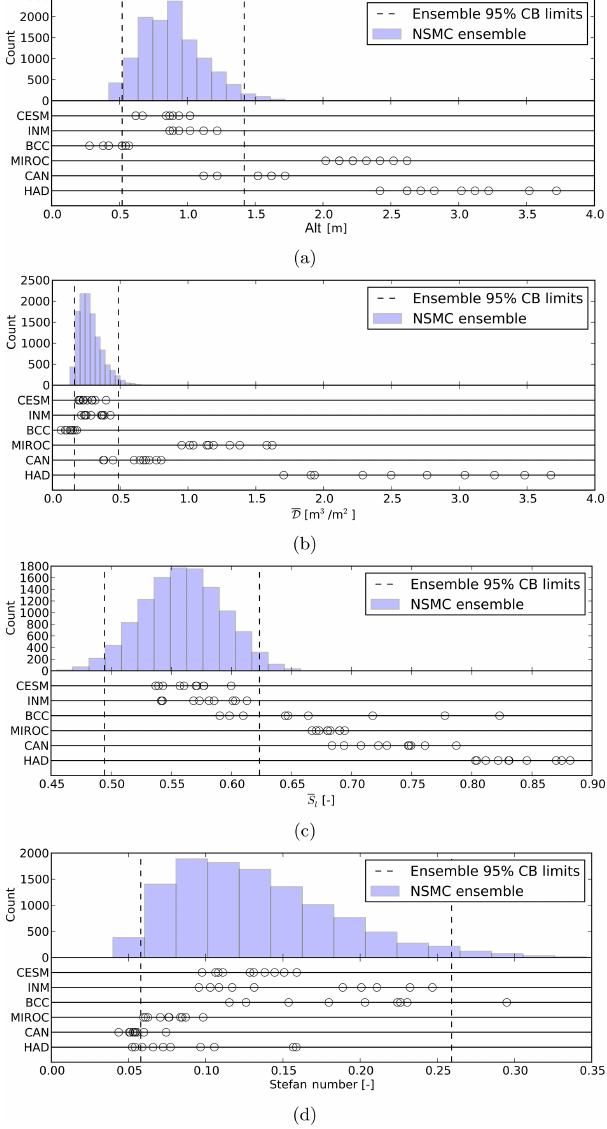
Figure 8. Comparison of (a) ALT, (b) annual thaw depth-duration, (c) annual mean liquid saturation, and (d) Stefan number projec- tion uncertainty due to soil property uncertainty (histograms) and structural climate model uncertainty (circles). Histograms include calibration-constrained ensemble values for years 2091 to 2100 (11530 values) based on the CESM8.5 climate model. Open circles below the histograms are values for the various climate models for the same years using the calibrated soil parameters (10 values each, except for BCC which has 9). NSMC ensemble 95% confidence band (CB) limits are indicated as vertical dashed